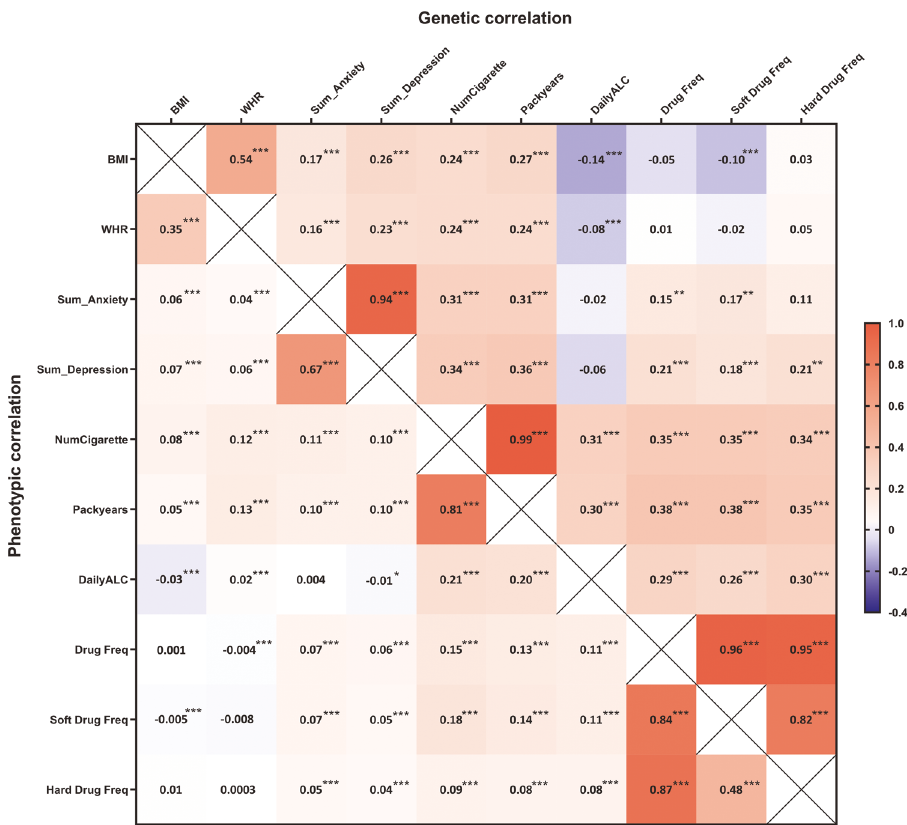
Fig. 4 Genetic and phenotypic correlations between obesity, anxiety, depression and substance use. BMI, body mass index; WHR, waist- hip-ratio; Sum_Anxiety, sum score of 10 items related to anxiety from MINI; Sum_Depression, sum score of 10 items related to depression from MINI; NumCigarette, number of cigarettes per day; DailyALC, daily alcohol intake; Drug Freq, lifetime drug use frequency; Soft Drug Freq, lifetime soft drug use frequency; Hard Drug Freq, lifetime hard drug use frequency; r G : genetic correlation; r P : phenotypic correlation. r G and r P adjusted for age, age 2 and sex. P -value(0): the difference of r G /r P from 0, ***p < 0.001, **p < 0.01, *p < 0.05 . We also test the difference of r G from 1, only r G between Numcigarette and Packyears had non-signi fi cant difference from